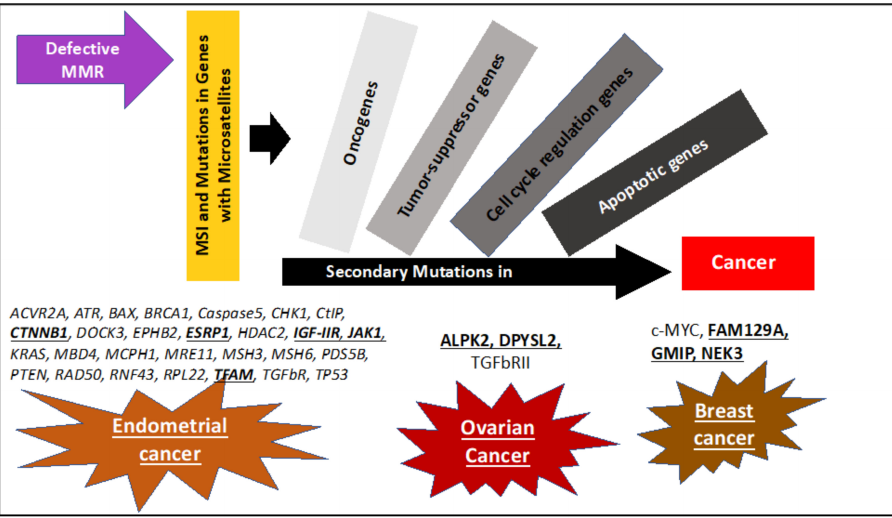
Figure 2. Steps in MMR deficiency (dMMR) / MSI cancer development leading to